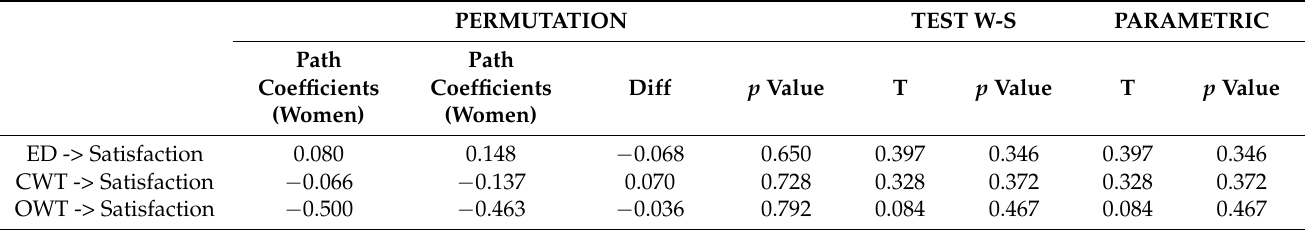
Table 8. Multigroup Analysis